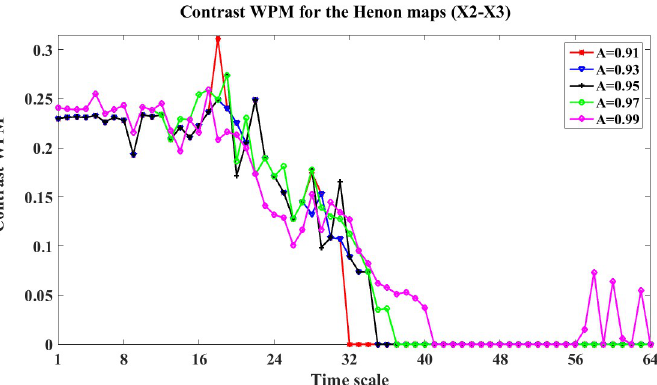
Fig 8. The contrast WPM for the four unidirectionally coupled Henon maps with different stopping criteria (X1-X3). This figure shows the contrast WM between X1 and X3: O